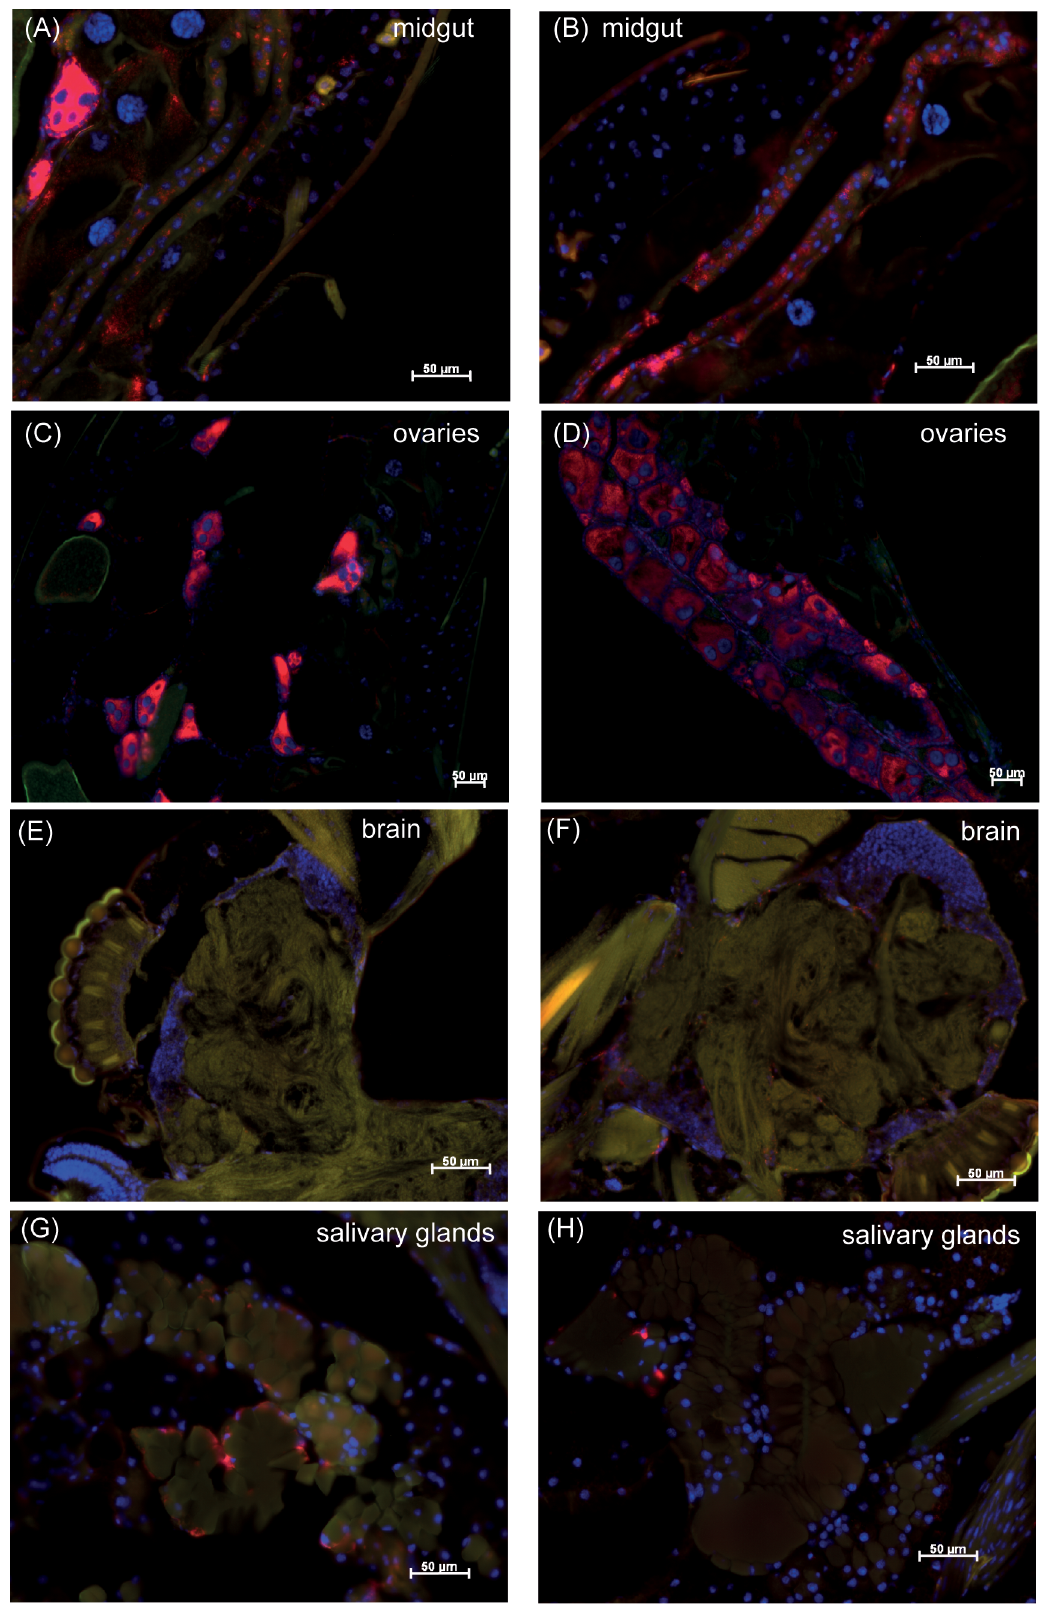
Figure 3. Localization of Wolbachia in different A.aegypti tissues visualized using FISH. Outbred laboratory w Mel (MGYP2.out) (A, C, G, E) and field-released w Mel ( w Mel.F) (B, D, F, H) mosquitoes at day 7 post DENV infection. Wolbachia stained in red (Alexa 594) and cell nuclei in blue